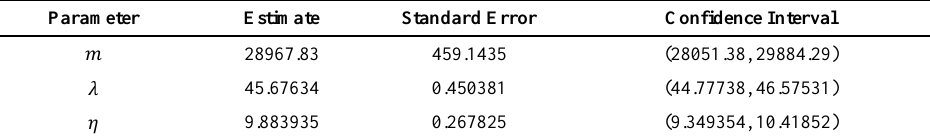
Table A13. Piedmont. Estimates, asymptotic standard errors and 95% mCIs for the parameters of the LOG model (2).